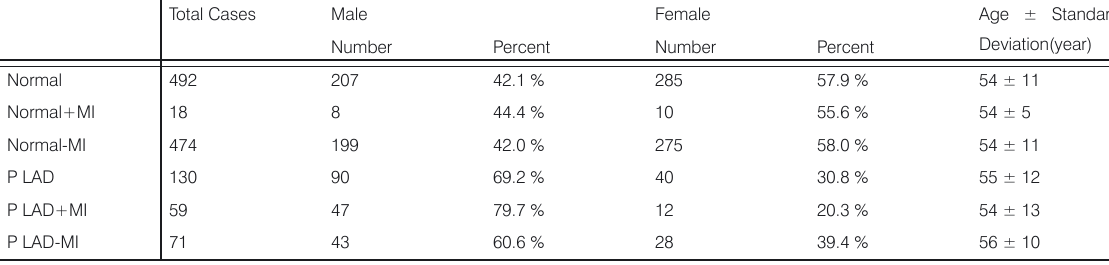
Table 1. Demographic features of different groups.